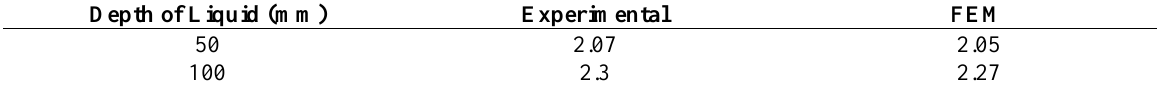
Table 2. Fundamental sloshing frequencies of liquid Depth of Liquid